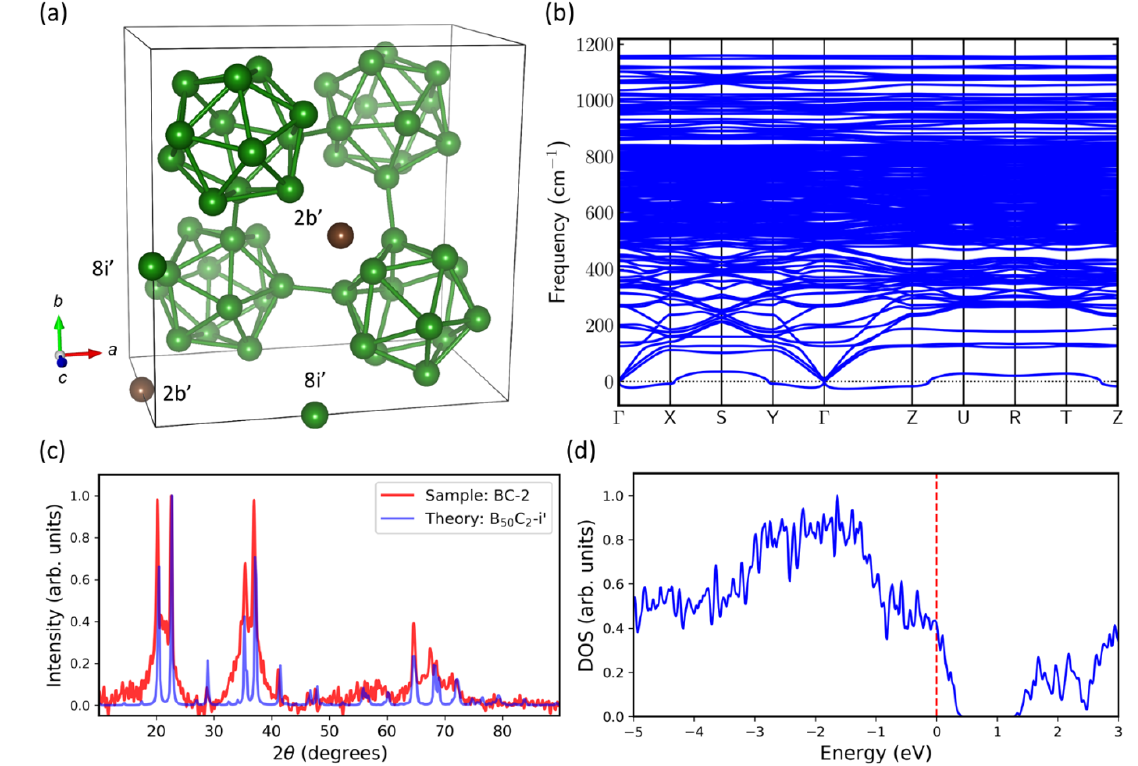
Figure 9. ( a ) The second lowest energy structure found in our density functional theory (DFT) calculations with full structure relaxation, B50C2-8i’. The tetragonal symmetry remains intact after relaxation. The positions of two carbon atoms move from 2b (0, 0, 0.5) to 2b’ (0, 0, 0.4855), and two boron atoms move slightly from 8i (0.4334, 0, 0) to 8i’ (0.4395, −0.0019, − 0.0091). ( b ) Phonon dispersion of B 50 C 2 -8i’ shows its dynamical instability. ( c ) Theoretical B 50 C 2 -8i’ X-ray diffraction (XRD) pattern (blue) compared with experimental XRD pattern of the sample BC-2 (red). ( d ) Electronic calculations show finite DOS of B 50 C 2 -8i’ at the Fermi level (red dashed line).